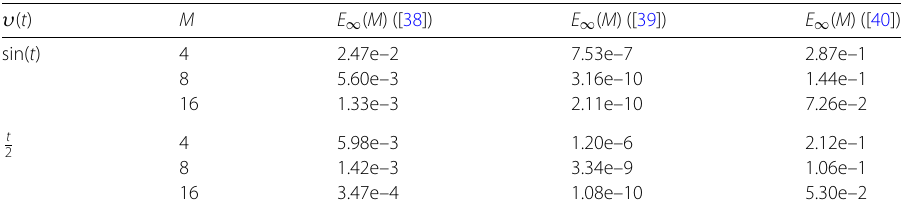
Table 3 Comparison of the MAE E ∞ ( M ) for Example